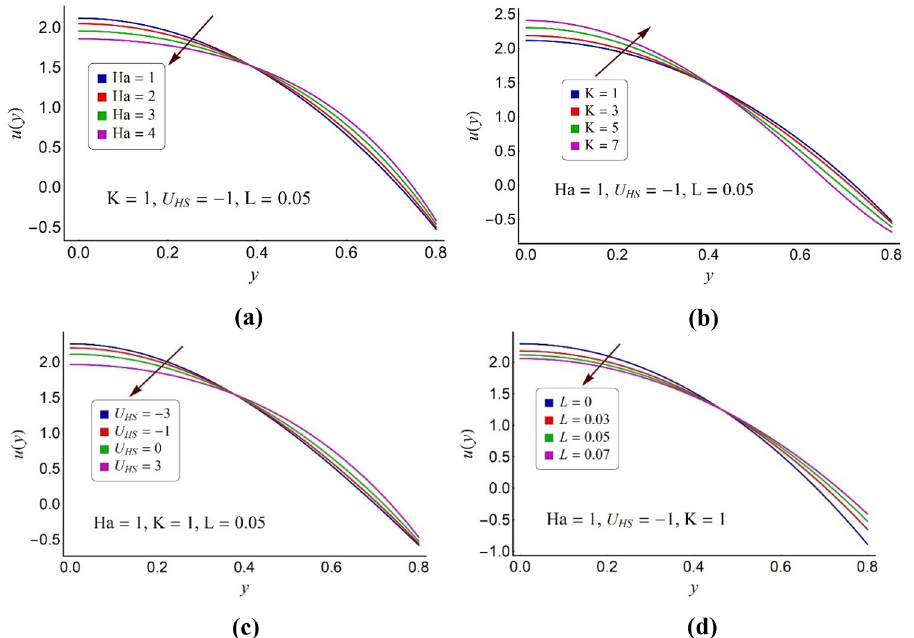
Figure 4. Alterations in velocity distribution of ternary fluid for various values of ( a ) Hartmann number Ha, ( b ) electroosmotic parameter K, ( c ) Helmholtz–Smoluchowski velocity U HS , ( d ) momentum slip parameter L